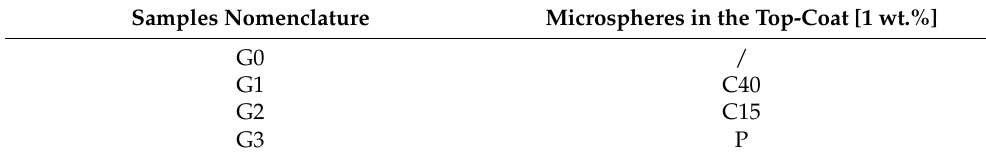
Table 1. Samples